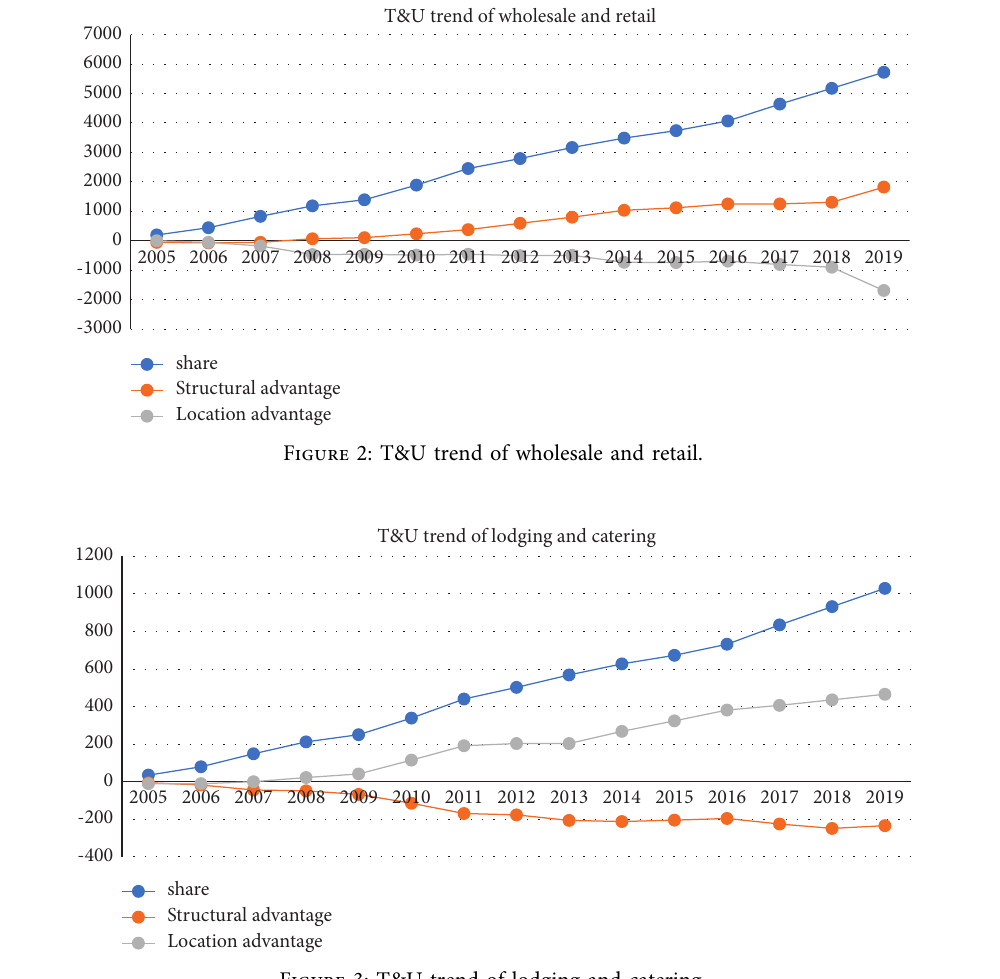
Figure 1: T&U trend of manufacturing.